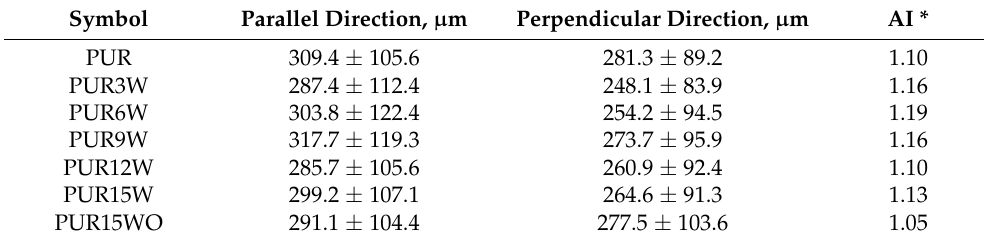
Table 3. Influence of vermiculite on the diameter of cells in PUR foams.